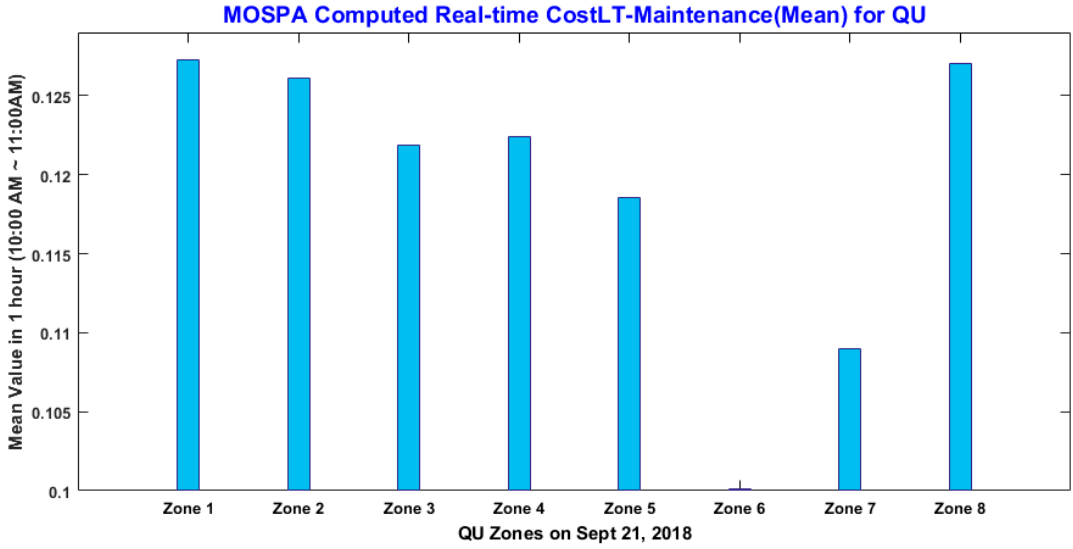
Figure 17. Lifetime Cost of QU Zones from Equation (17) (Section 4).